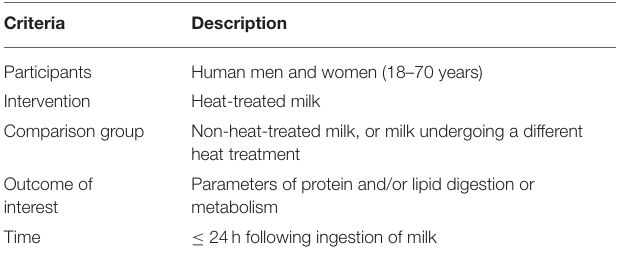
TABLE 1 | PICOT criteria employed to define the research